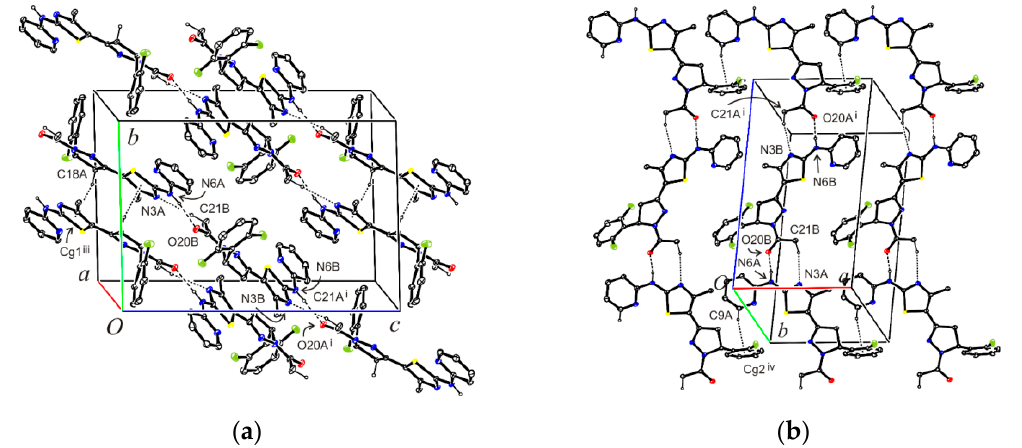
Figure 8. Two views of the unit cell ( a ) and ( b ) showing N ― H···O and C ― H···N hydrogen bonding and C ― H··· Cg intermolecular interactions in the crystal structure of 6 . The H atoms not involved in hydrogen bonds have been omitted for clarity; Cg 1 = thiazole system, Cg 2 = phenyl system.